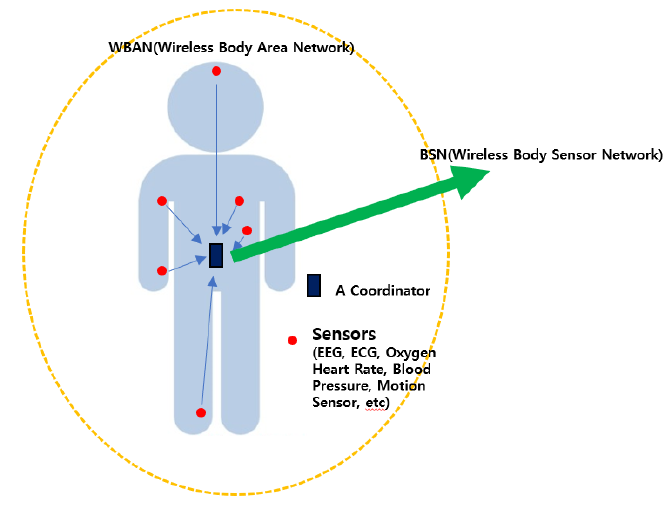
Figure 2. Example of patient monitoring in a wireless body area network.